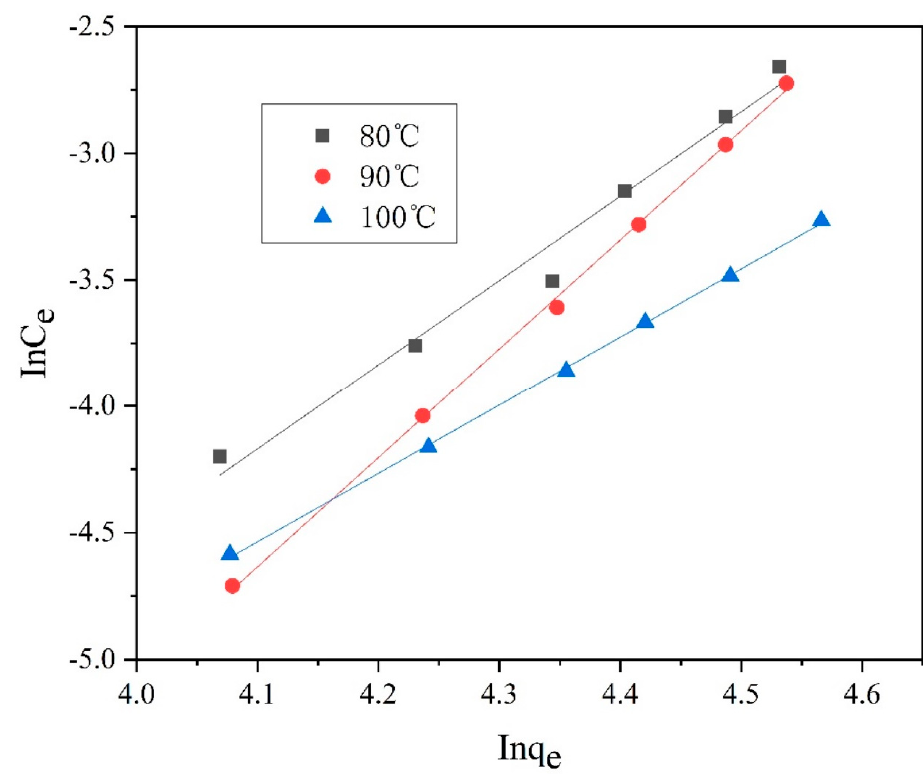
Figure 15. Freundlich model of dyeable spandex dyed with neutral red G.